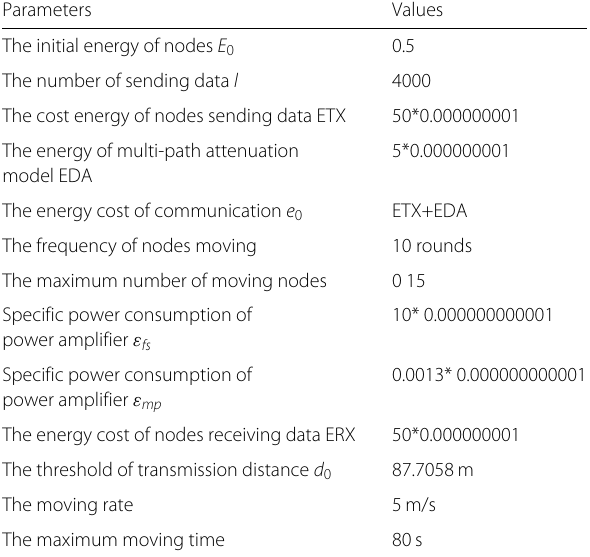
Table 3 Parameters and values